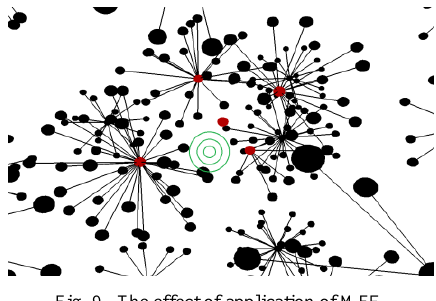
Fig. 9. The effect of application of MFE.